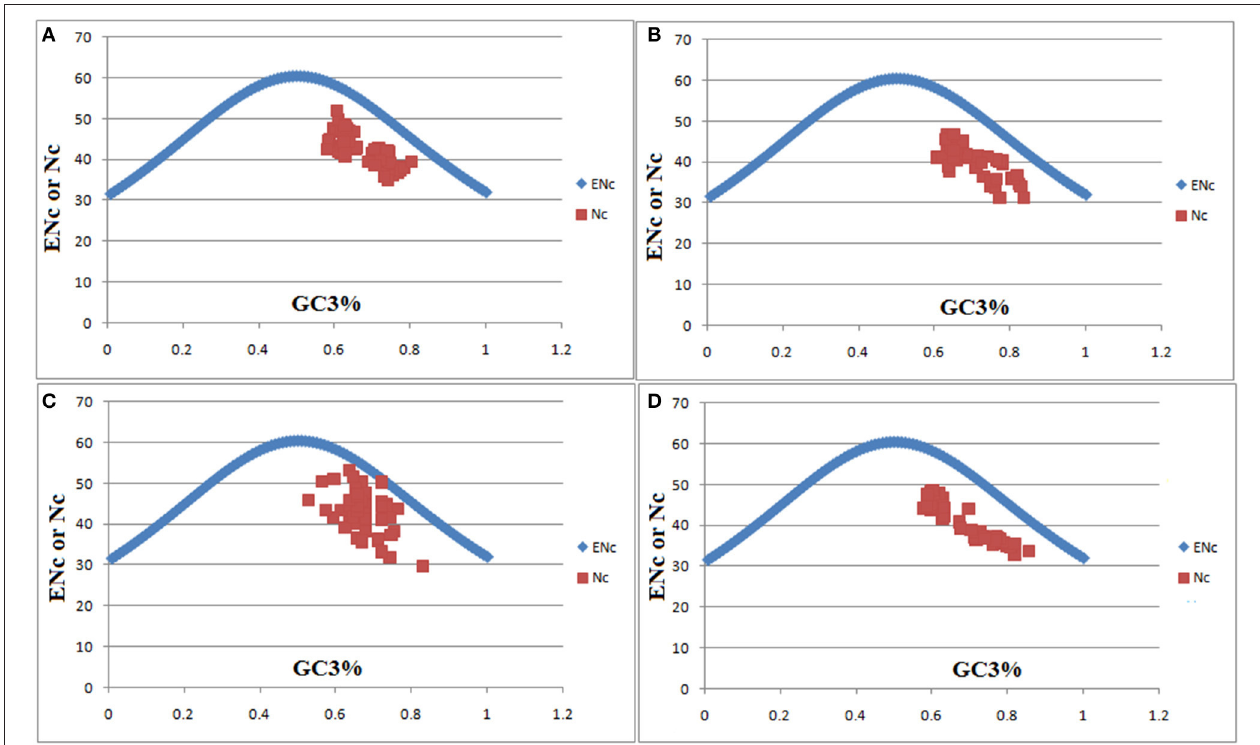
FIGURE 7 | ENc plot analyses (ENc or Nc plotted against GC3) of pqq genes; pqqB (A) , pqqC (B) , pqqD (C) , and pqqE (D) from Klebsiella , Kosakonia , Pantoea , Rahnella , and Serratia . ENc represents the effective number of codons, and GC3 is the GC content of synonymous codons at the third position. In the plot, the ENc from GC3 were shown as a bell-shaped bisymmetric curve. The solid line represents the expected curve when codon usage bias is only affected by mutational pressure. Nc was obtained from Codon W 1.4.4 (http://codonw.sourceforge.net/, Pedan, 2000). Due to the short length of the pqqA gene (23–25 amino acids), numerous codons were absent and, in consequence, Nc values were not calculated through CodonW.